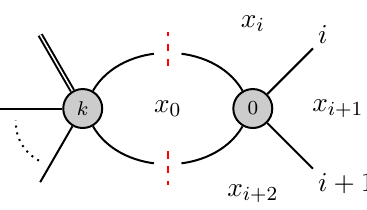
Figure 2 . The only two-particle cut contributing to the IR divergent part of the form factor as well as to the dual conformal